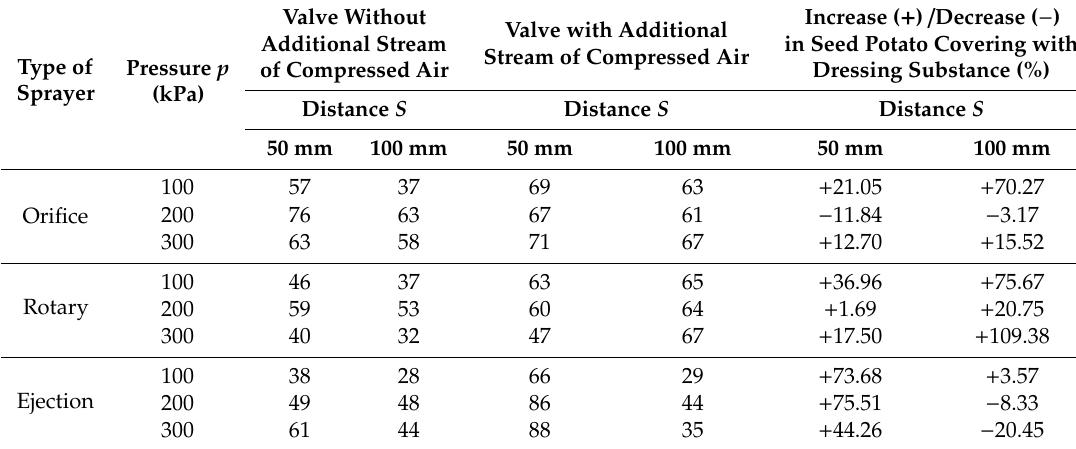
Table 2. The percentage of seed potato covering with the dressing substance.